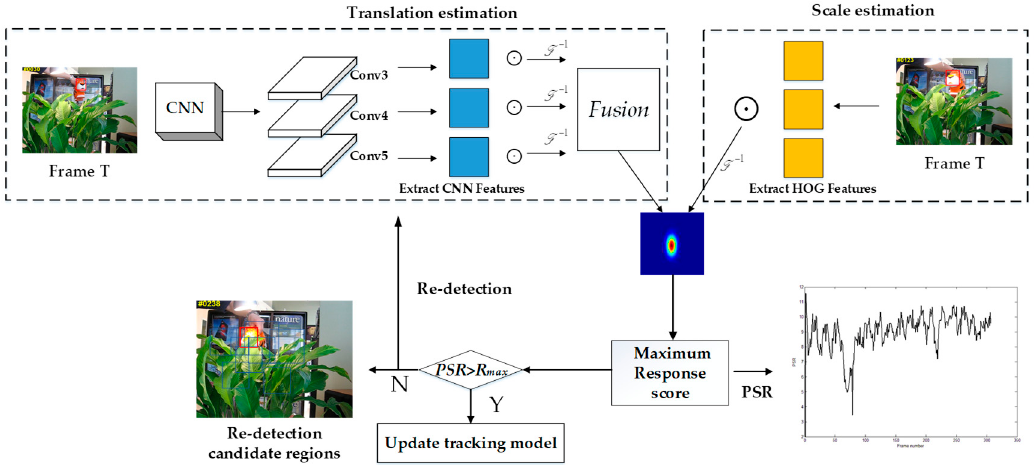
Figure 1. The overall framework of the proposed visual tracking algorithm.